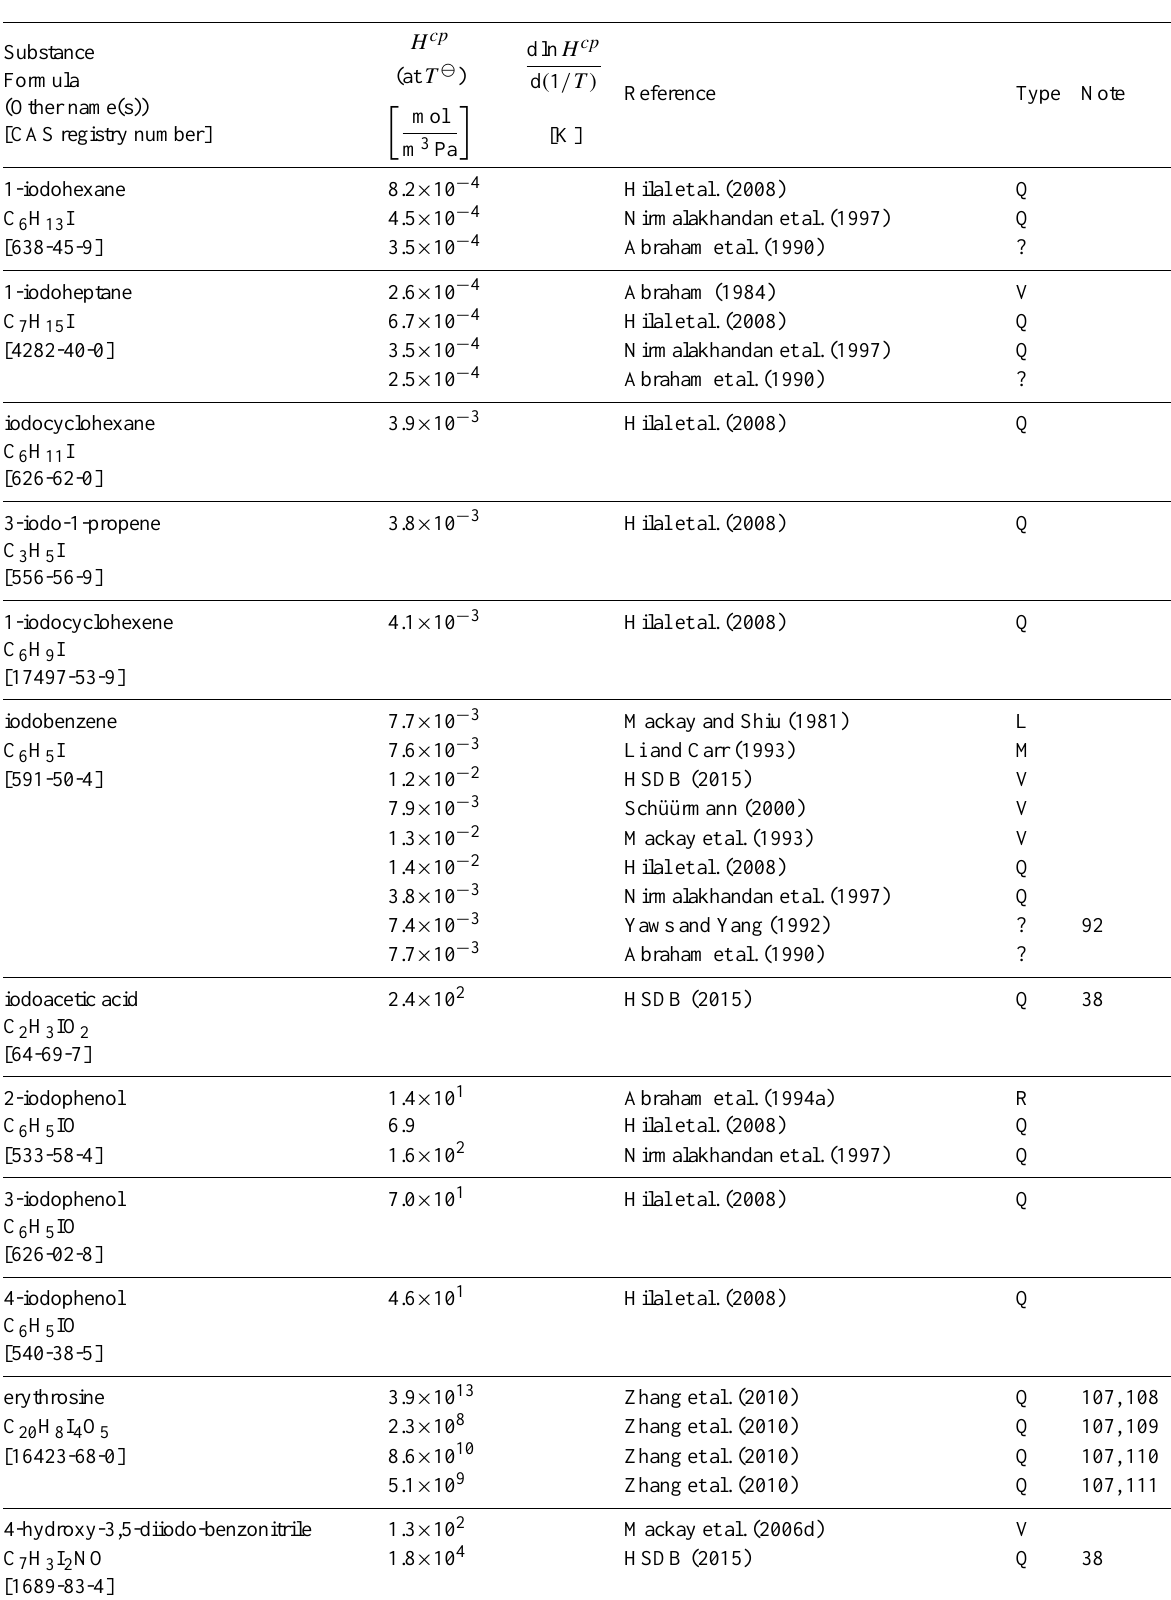
Table 6: Henry’s law constants for water as solvent